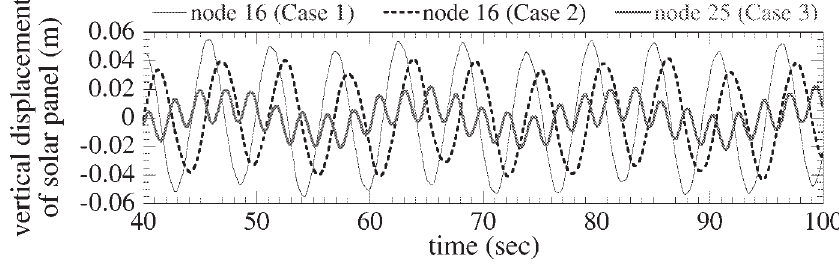
Fig. 12. Time responses of the largest residual vibration of solar panel for all